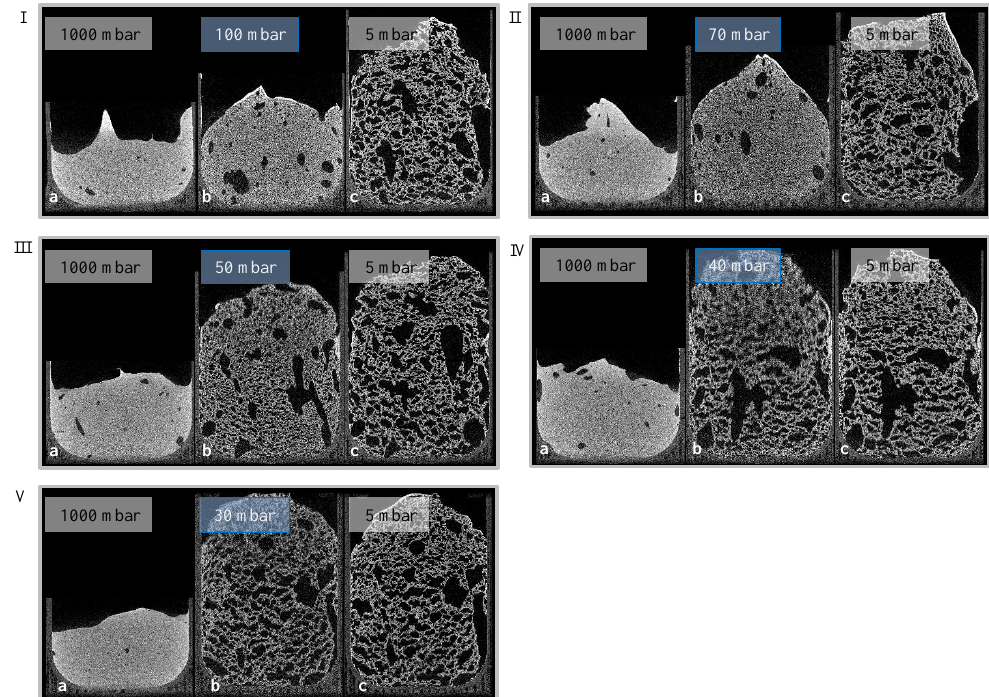
Figure 7. Holding stages (I: 100 mbar, II: 70 mbar, III: 50 mbar, IV: 40 mbar, V: 30 mbar) of a 23 °C tempered suspension with a pressure reduction rate of 10 mbar/s (( a ) suspension; ( b ) holding stage; ( c ) foam).